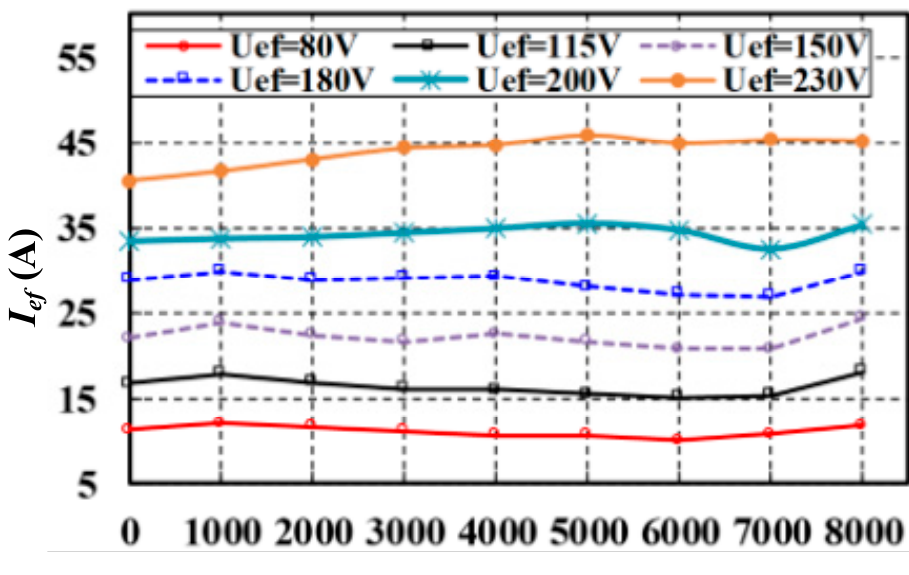
Figure 21. The curve of excitation current I ef changing with speed.